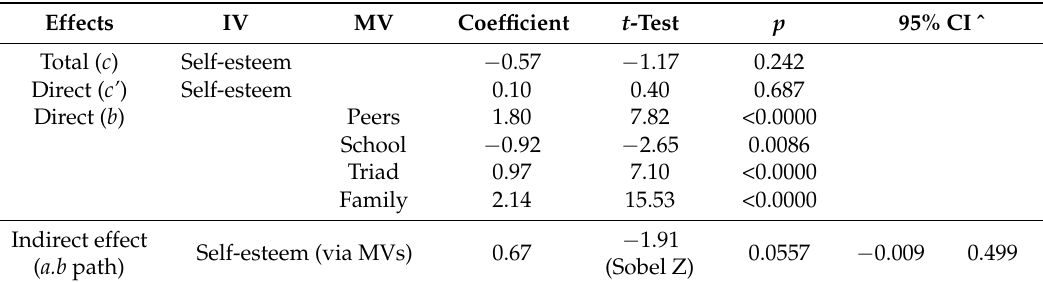
Table 6. Mediating analysis of contextual factors on the relationship between self-esteem and violence of youth